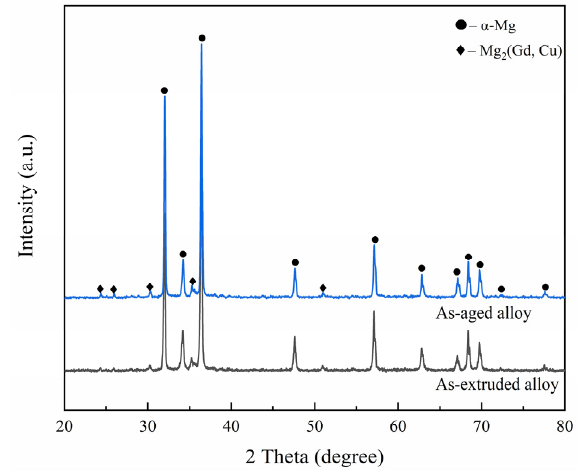
Figure 3. XRD patterns of the Mg–6.0Gd–1.2Cu–1.2Zr alloy.